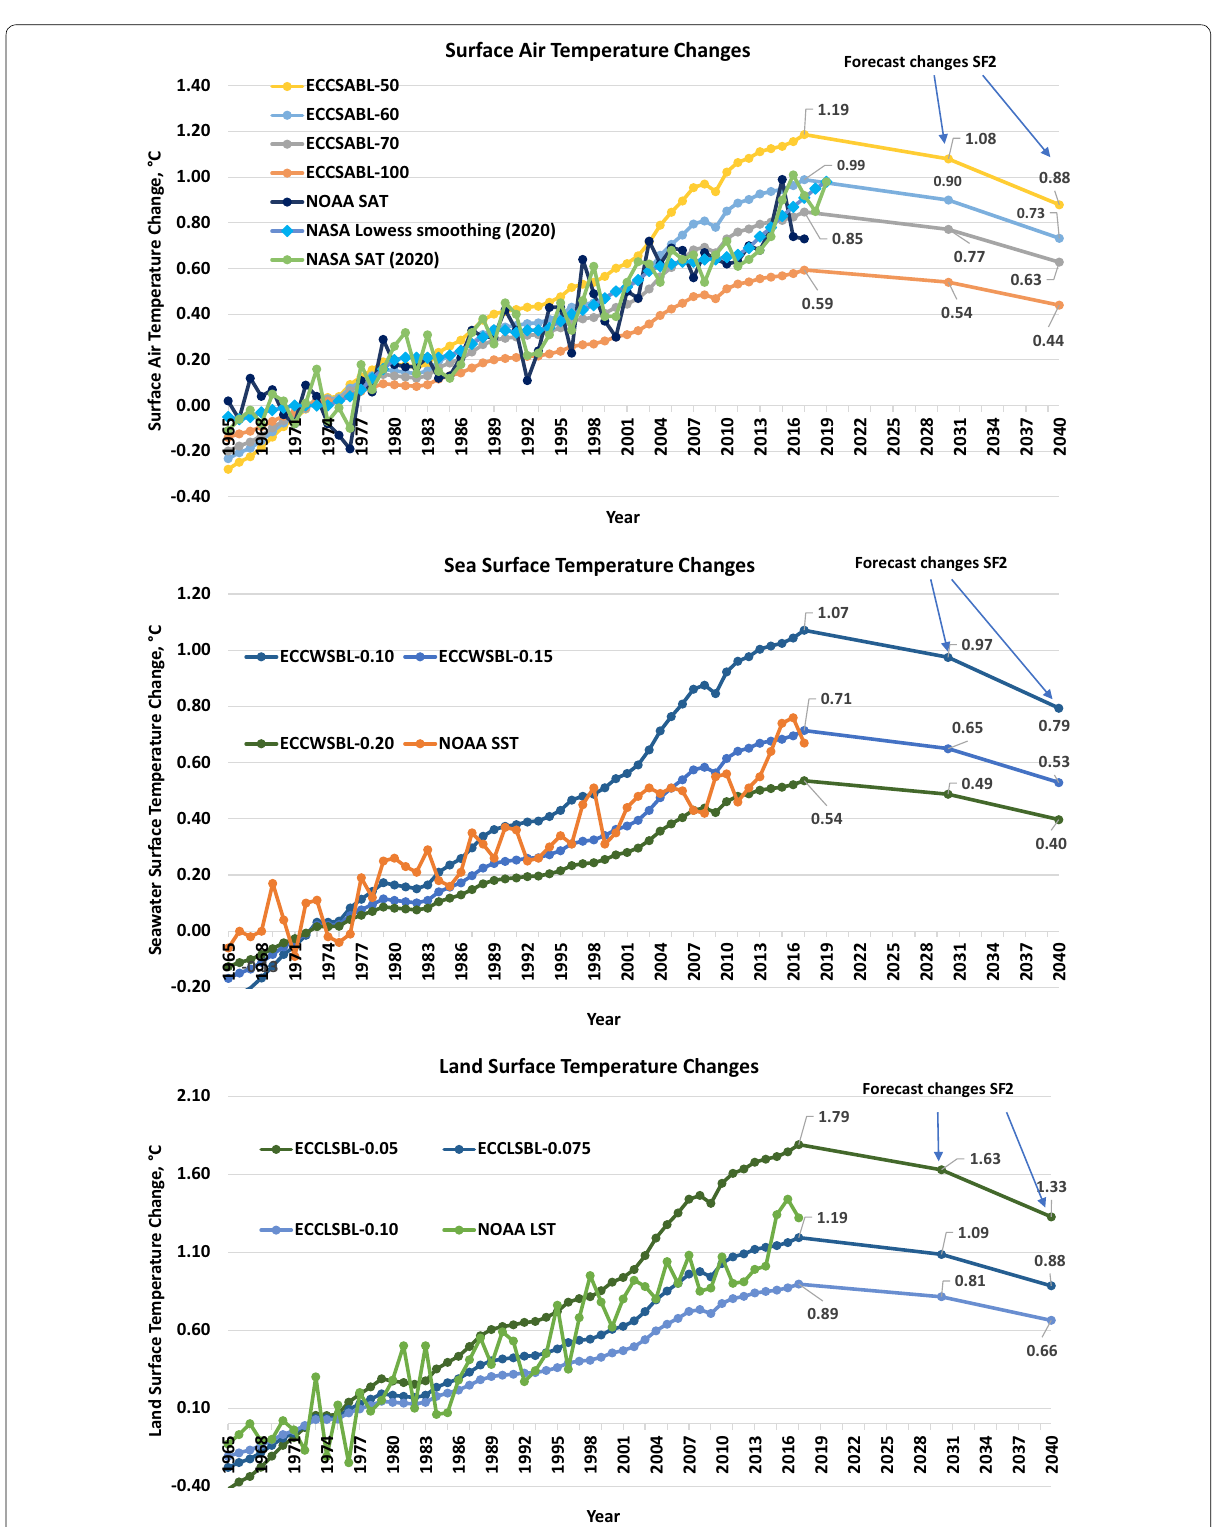
Fig. 4 Calculated past temperature changes at the lower and upper depth limits of equivalent climate change surface air boundary layer (top), equivalent climate change waters surface boundary layer (middle), and equivalent climate change land surface boundary layer (bottom), and the temperature change forecast as well as their observed temperature anomalies under scenario